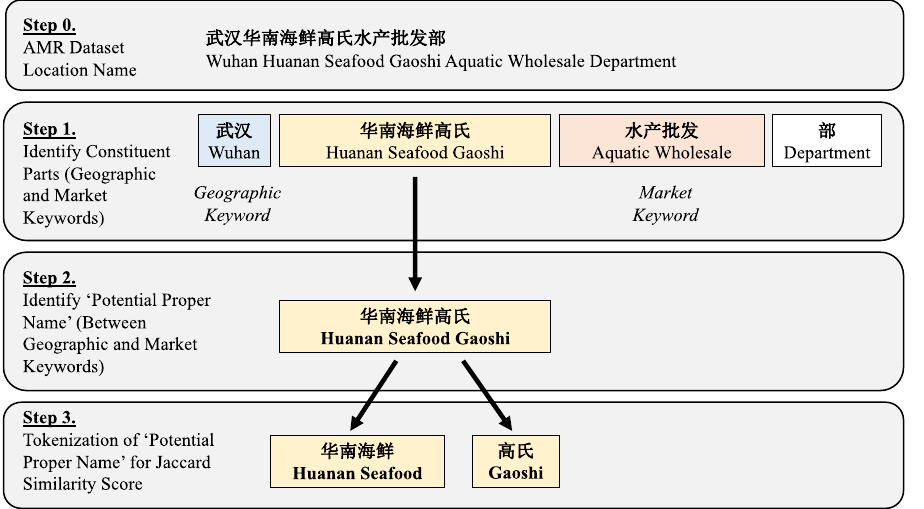
Figure 2. Identifying ‘potential proper names’ in AMR dataset